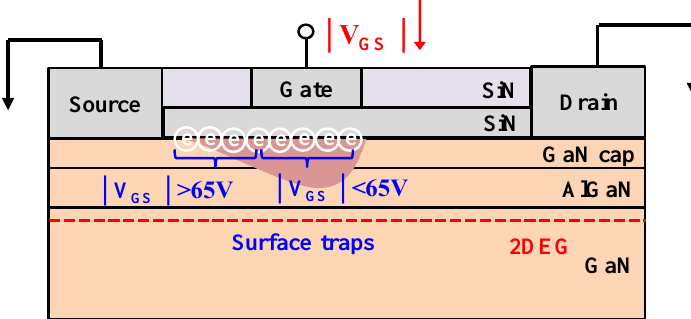
Figure 5. Schematic diagram of a device illustrates possible electron trapping that mainly depletes 2DEG in the channel under high voltage off-state gate stress and causes R on degradation.